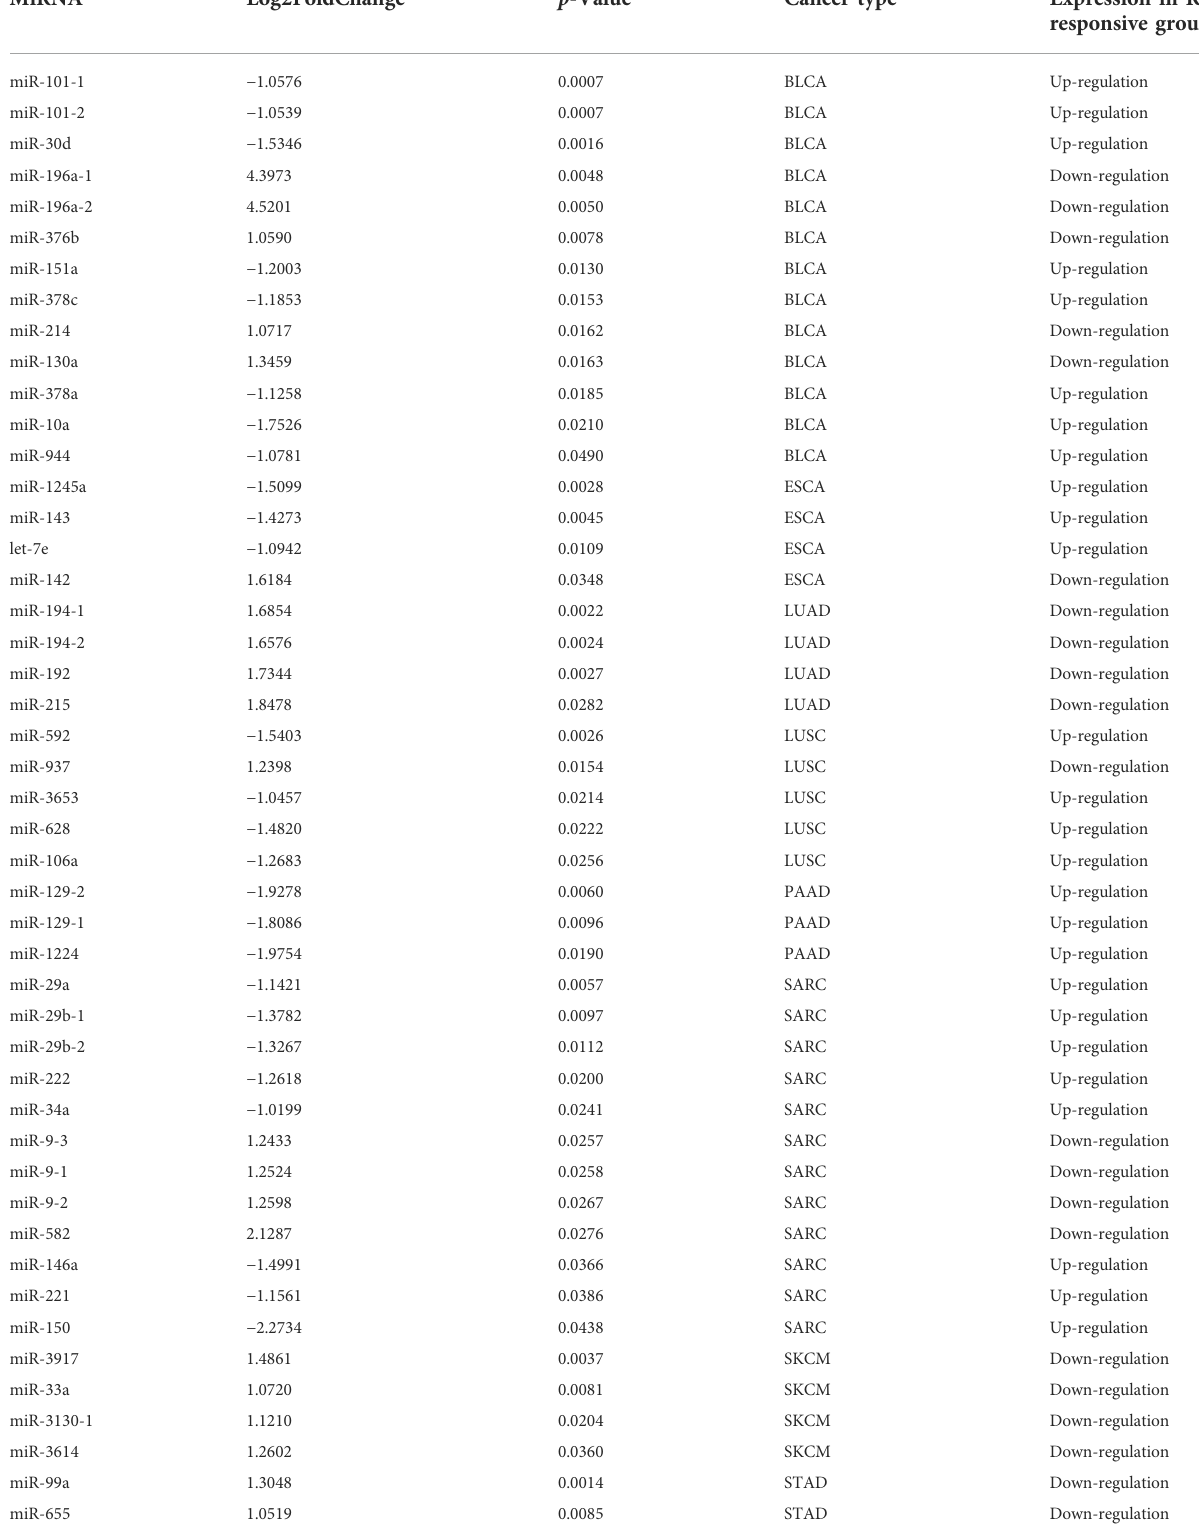
TABLE 1 The differentially expressed miRNAs (DEMs) between RT responsive group (S) and the progressive disease group